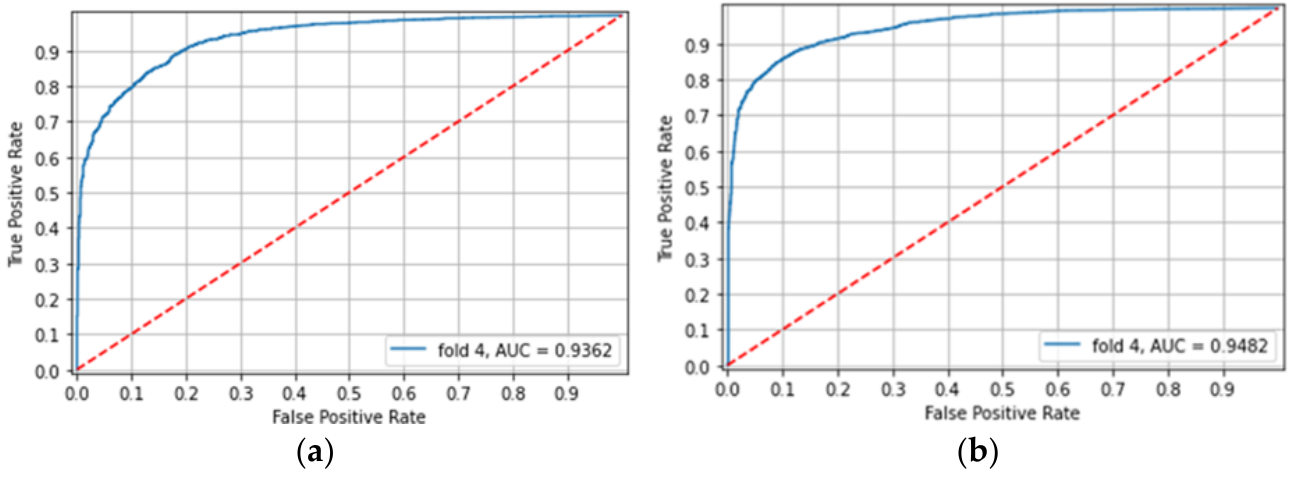
Figure 2. Experiment 2: ( a ) Classification of PillCam Crohn CE images by a model trained on PillCam SB3 CE images ( b ) Classification of PillCam SB3 CE images by a model trained on PillCam Crohn CE images.